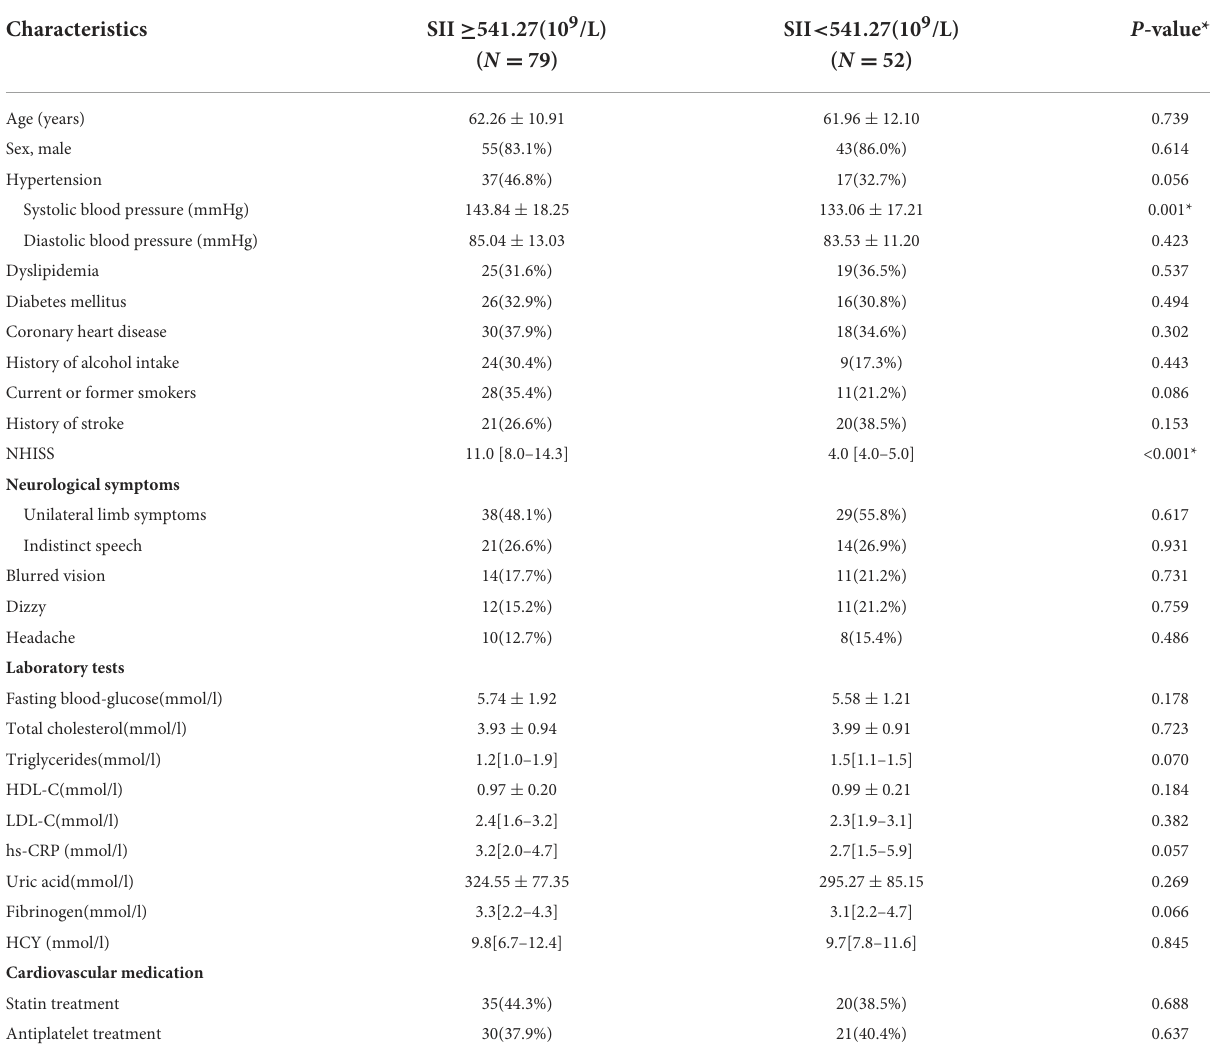
TABLE 1 Baseline data of patients according to SII level ( N = 131). Characteristics